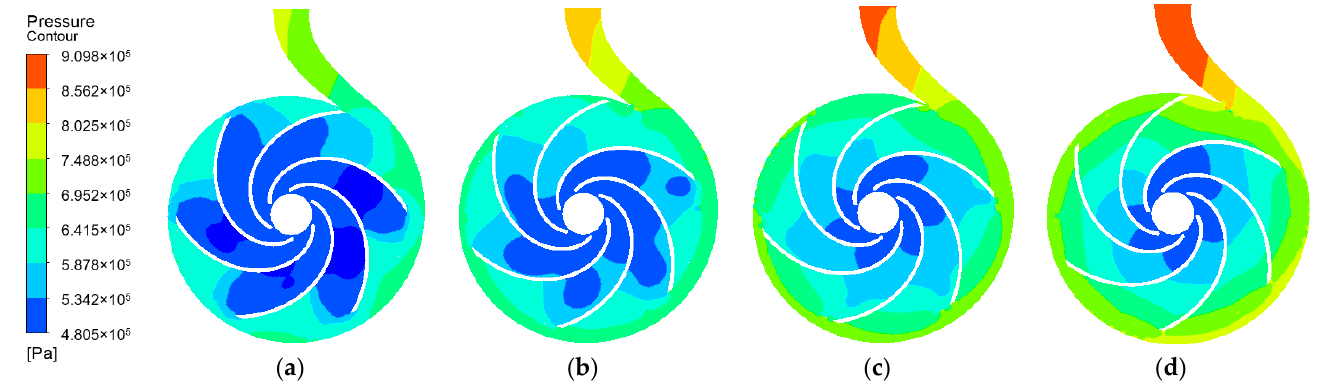
Figure 7. Pressure distribution of axial vertical plane at α g = 0.15. ( a ) t = 1 s; ( b ) t = 2 s; ( c ) t = 3 s; ( d ) t = 4 s.